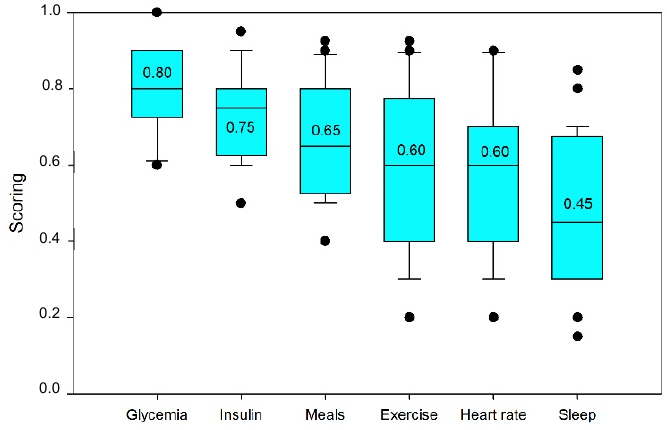
Figure 2. Feature selection ranking.